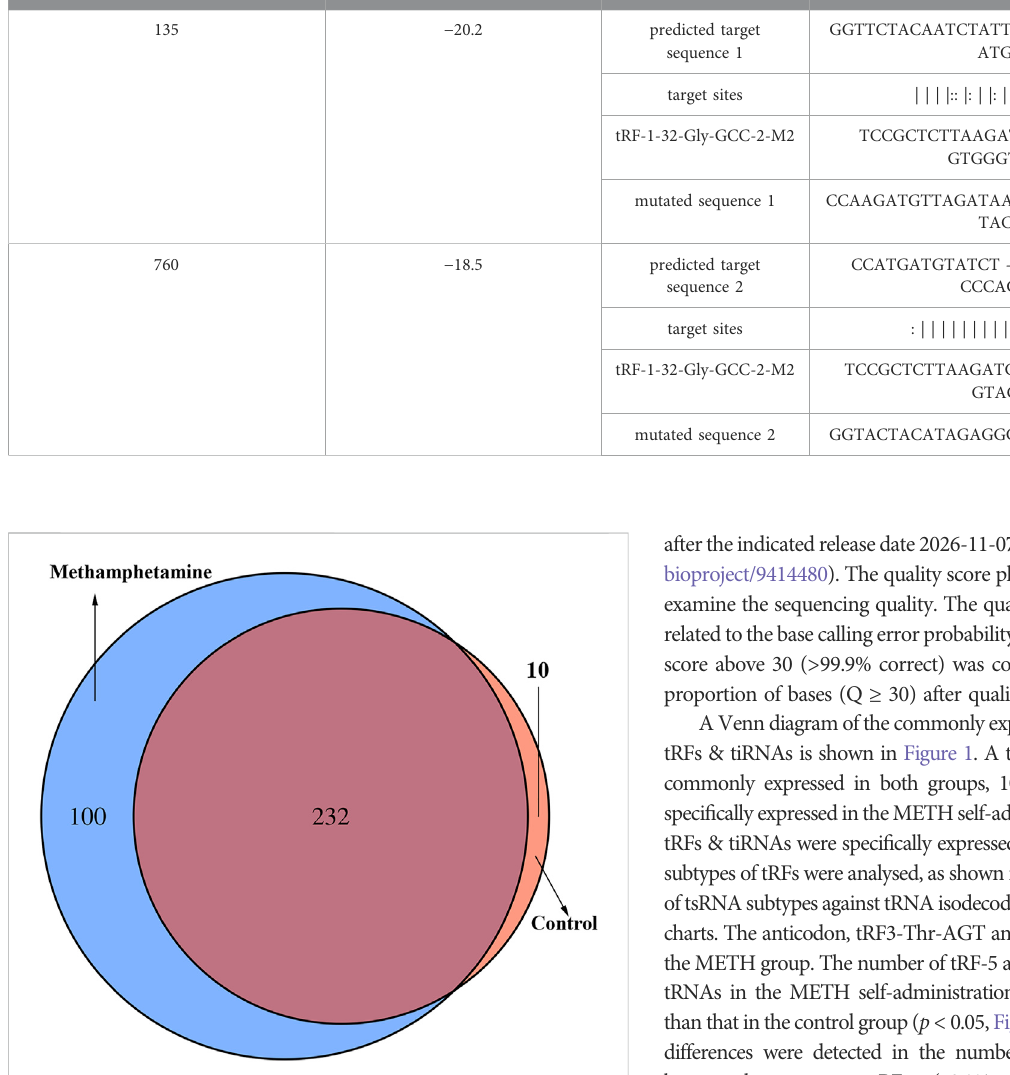
TABLE 2 A schematic of the base pair regions of the BDNF 3 9 UTR and the predicted binding sites for tRF-1-32-Gly-GCC-2-M2. Leftmost position of BDNF 3 ′ UTR